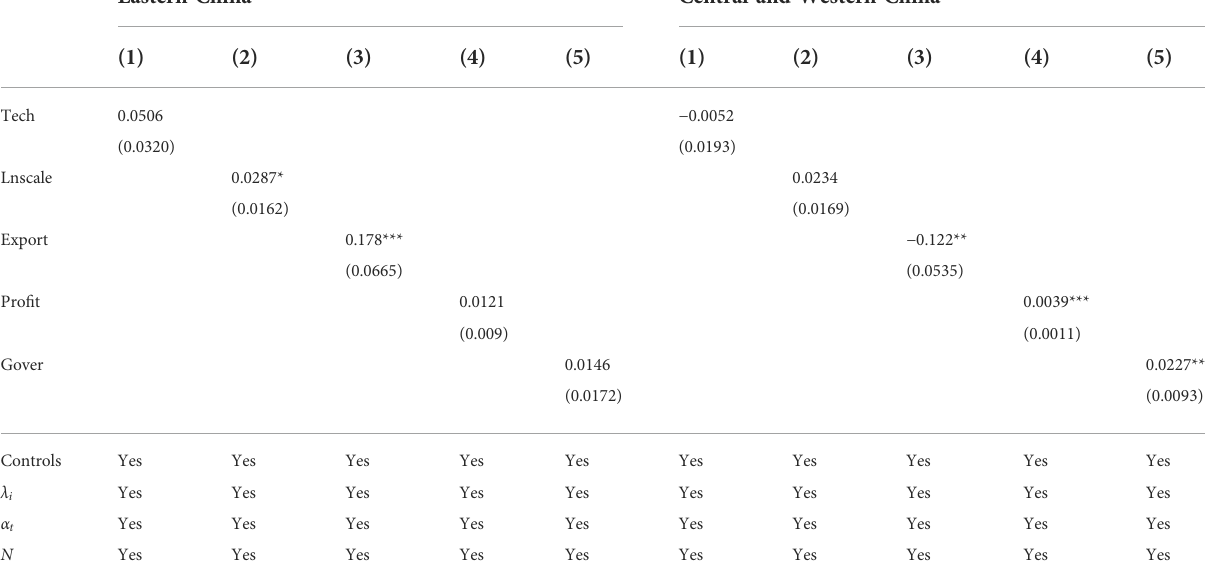
TABLE 6 Regional differences of FDI heterogeneity quality characteristics on carbon emission intensity. Eastern China Central and Western